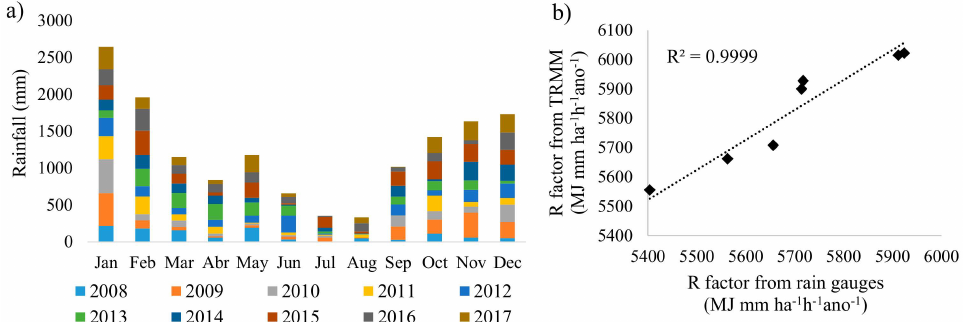
Figure 4. ( a ) Annual rainfall distribution from 2008 to 2017 from a station located in the study site, ( b ) R-Factor obtained from the Tropical Rainfall Measuring Mission (TRMM) compared to that obtained from the monthly rain gauges data.